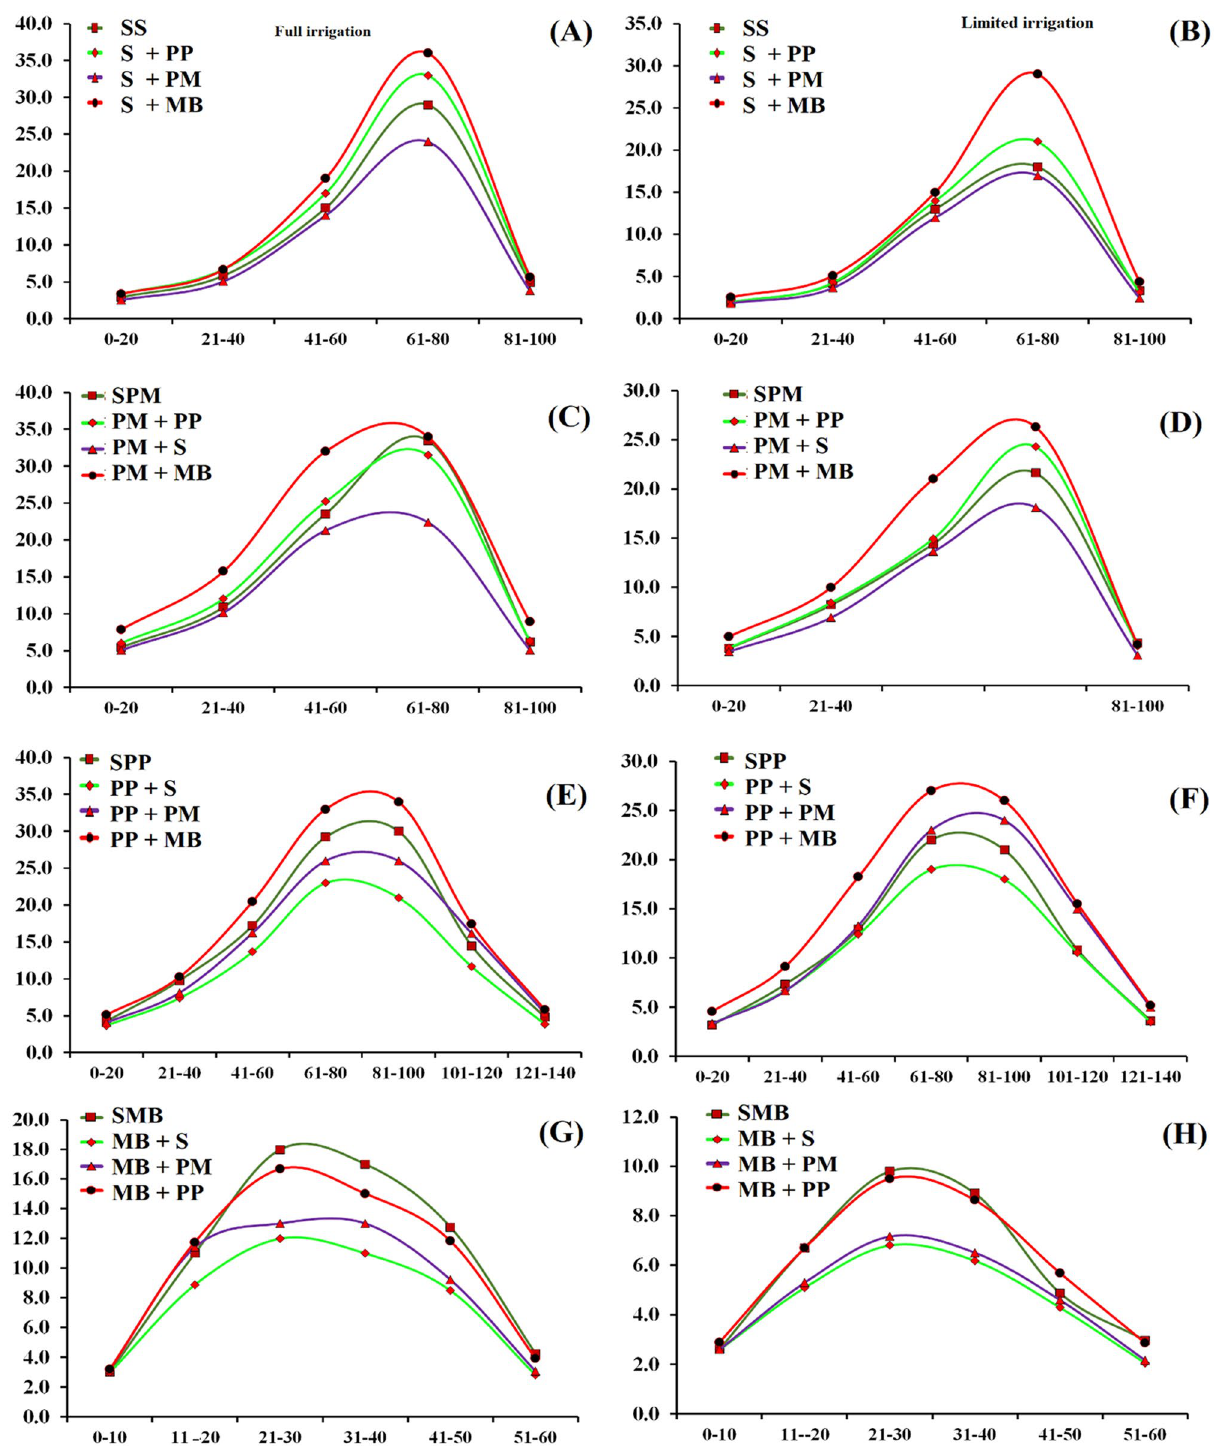
Figure 2. Crop growth rate of summer cereal and legumes crops as affected by intercropping and irrigation regimes. PM, MB, S and PP stand for millet, mungbean, sorghum and pigeon pea, Stem dry weight of winter crops (g m −2 ) at anthesis stage. Data regarding stem dry weight (SDW) (g m −2 ) is presented in Table 1. Higher SDW at anthesis was recorded under full irrigation than limited irrigation. Cereal crops (barley or wheat) intercropped with fababean produced maximum SDW (g m −2 ) at anthesis, than when intercropped with each other (Table 2E,F), respectively. Wheat and barley intercropped with fababean produced higher SDW m −2 at anthesis, followed by intercropped with rapeseed, while the lowest SDW plant −1 for both wheat and barley were observed when intercropped with each other. Fababean sown as sole crop produced